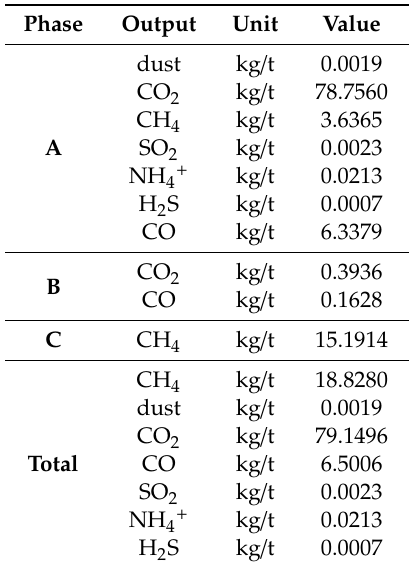
Table 2. Emission inventory of liquefied natural gas production in the Shanxi Province (per unit). Phase Output Unit